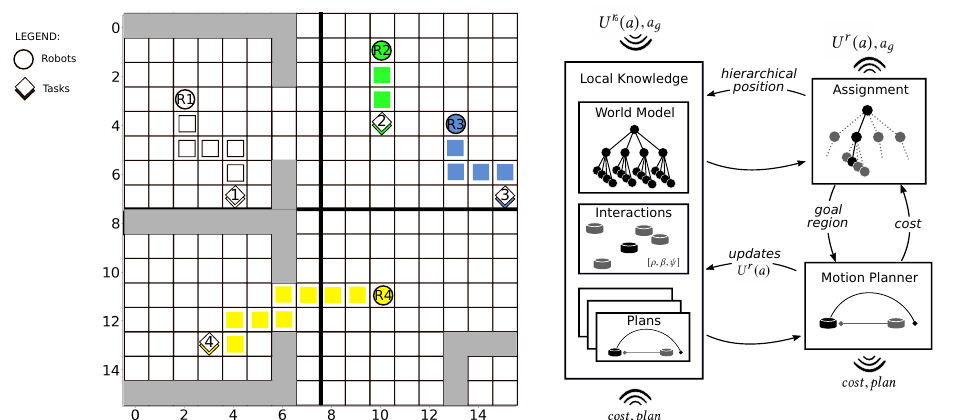
Figure 1. Left : example outcome of Hierarchical Task Assignment and Path Finding (HTAPF) with four robots and four tasks in a 16 × 16 grid world, here divided in 4 sub-areas. Robots move to the closest cell with a Manhattan neighborhood, and share their plan with other robots within the communication range. Conflicts are resolved by sequential planning, exploiting the knowledge of others’ plans for task assignment and collision-free path planning. In the image, each robot is identified by its unique color and number, i.e., r 1 white, r 2 green, r 3 blue, r 4 yellow. Grey regions are walls. Right : Interaction scheme among the different components of HTAPF. The local knowledge of robot r stores the world model, the estimated area utilities obtained upon interaction with other robots, and the received plans from other robots. Both the area assignment process and the motion planner exploit and update the local knowledge and interact with each other with local information